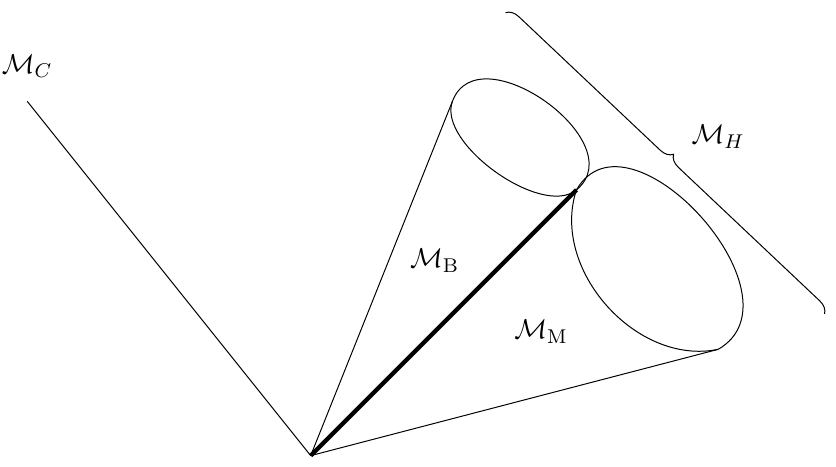
Figure 4 . Schematic picture of the Coulomb Branch, , and Higgs Branch, , of SCQD with M C M H 8 supercharges at finite coupling. The Higgs Branch is a union of two cones, the mesonic cone, M , and the baryonic cone, B , with non-trivial intersection (line in M M